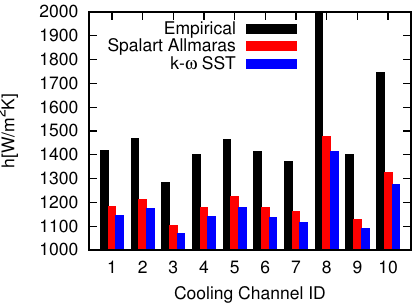
Figure 3. Comparison of the heat transfer coefficients of the cooling channels computed by the two approaches.